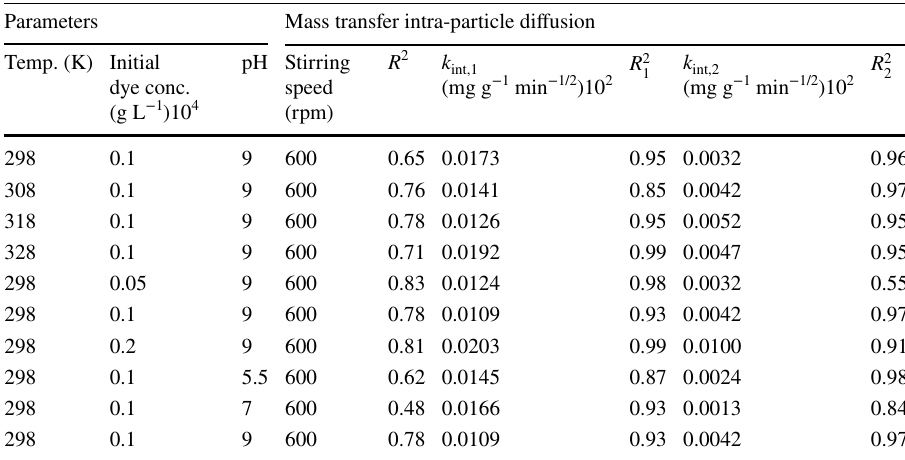
Table 4 Calculated kinetic models and some results of